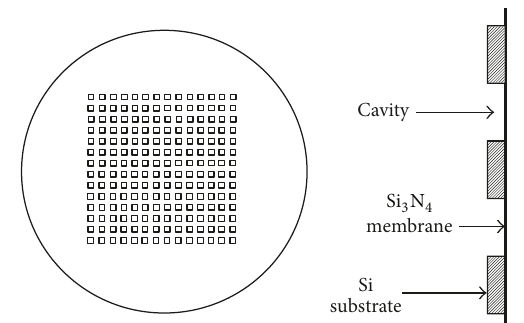
Figure 2: Schematic arrangement (not to scale) for a silicon subs- trate periodically perforated, with 196 cavities of 1×1𝜇 m 2 each